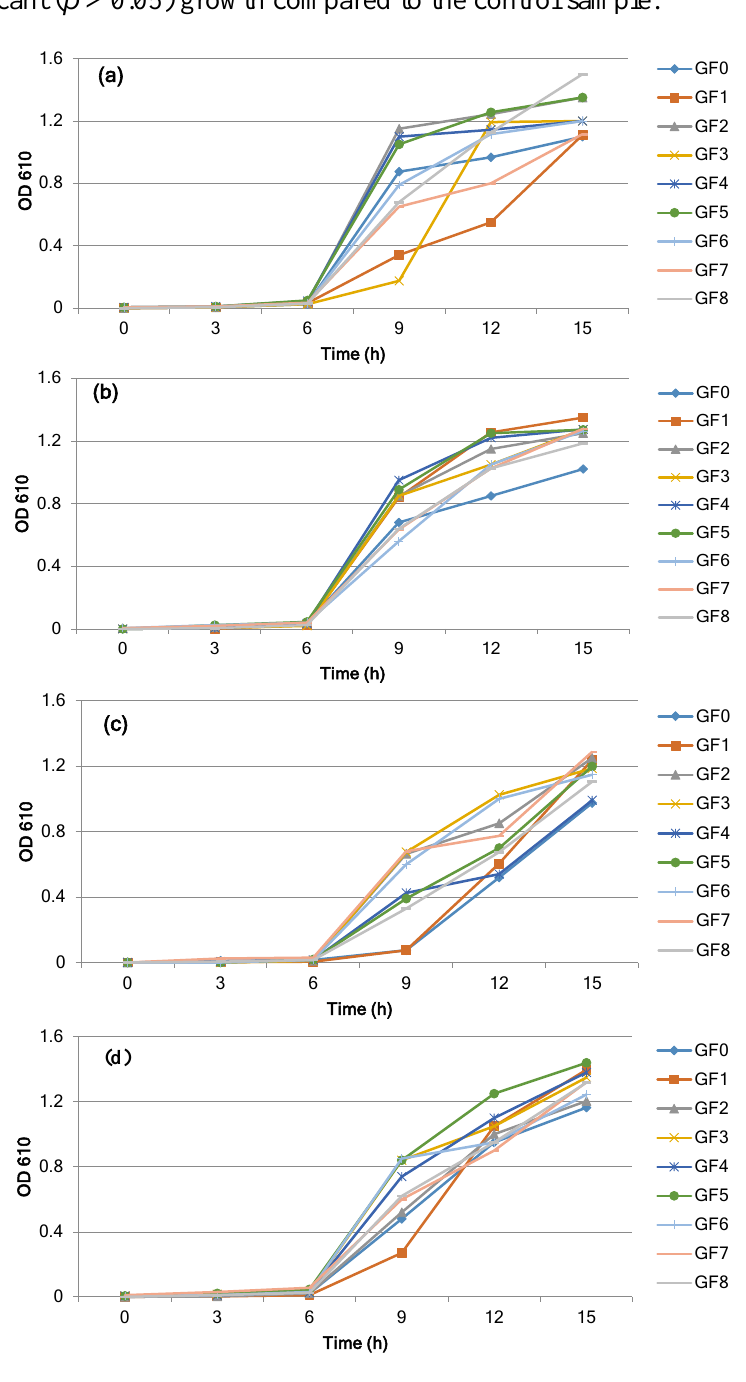
Figure 1. Changes in growth during incubation of L. reuteri strains ( a ) DSM 20016, ( b ) SD2112, ( c ) CF2-7F, and ( d ) MF2-3 at 37 °C in the basal medium with different protein sources: GF1-proteose peptone, GF2-peptone, GF3-tryptone, GF4-proteose peptone #3, GF5-phytone peptone, GF6-tryptic soy broth without dextrose, GF7-yeast extract, GF8- beef extract, GF0-control (no protein